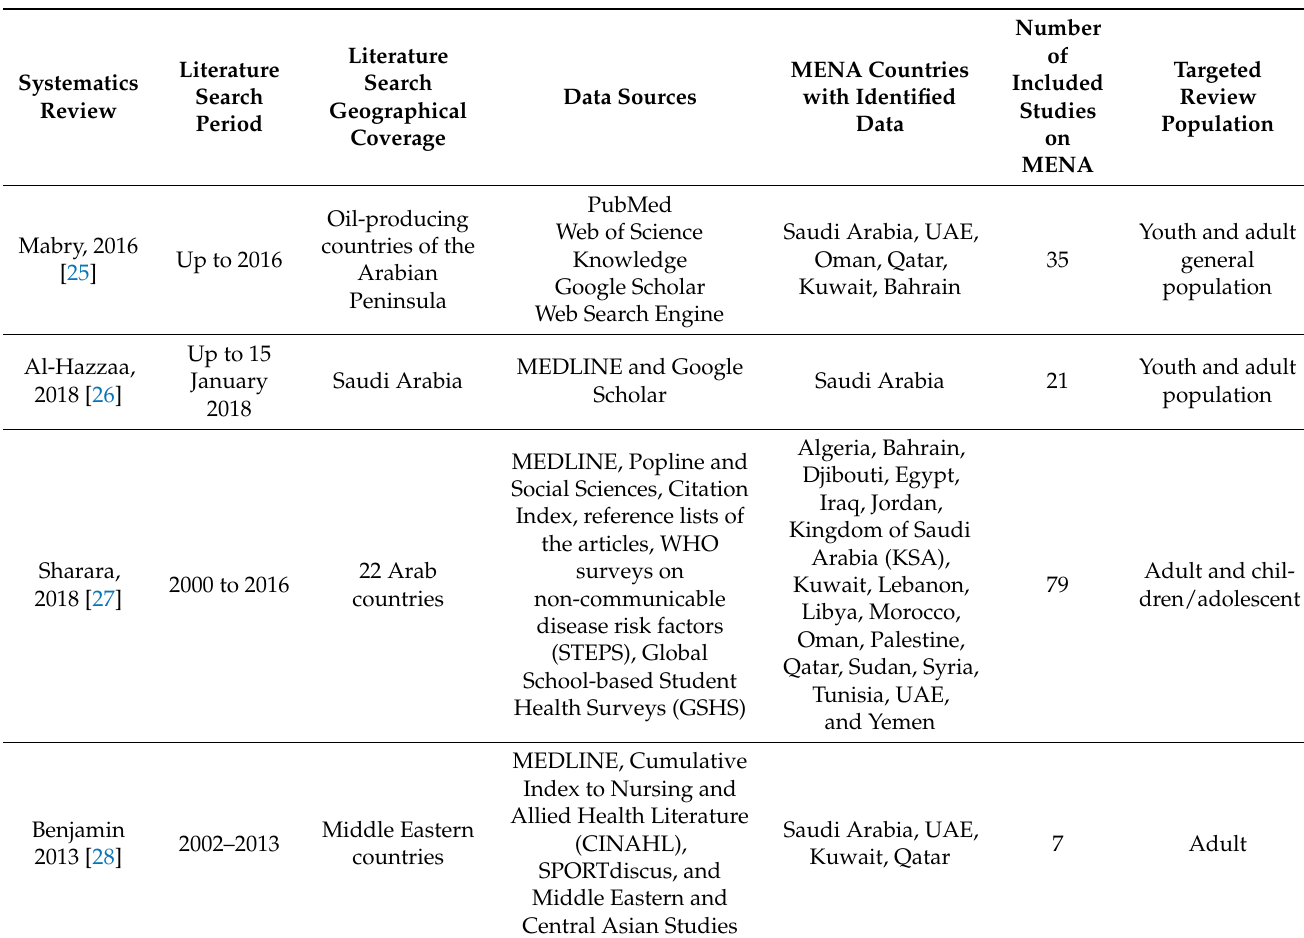
Table 1. List of included systematic reviews with data on factors (barriers and facilitators) associated with physical activity in Middle East and North Africa (MENA)